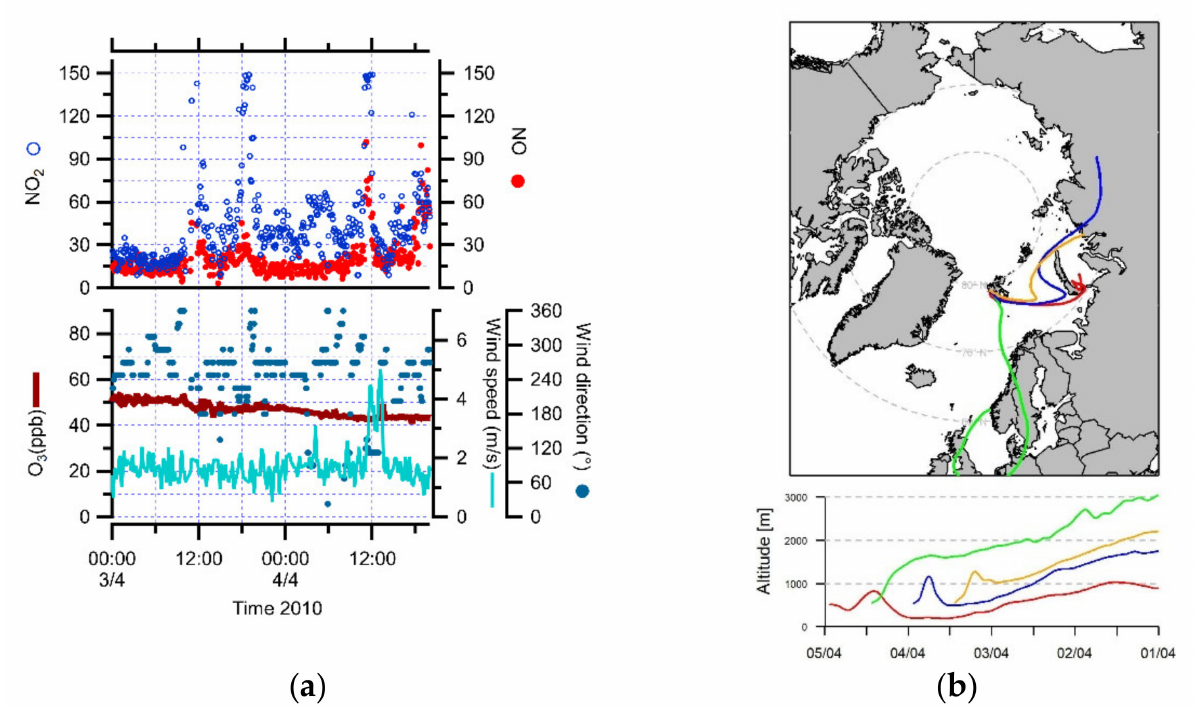
Figure 2. ( a ) NO, NO 2 , O 3 concentrations, wind speed and direction during the transport events from Russia (3 April 2010) and Europe (4 April 2010). ( b ) 5-day back trajectories for 3 and 4 April 2010 at 23:00 UTC, calculated every 12 h above